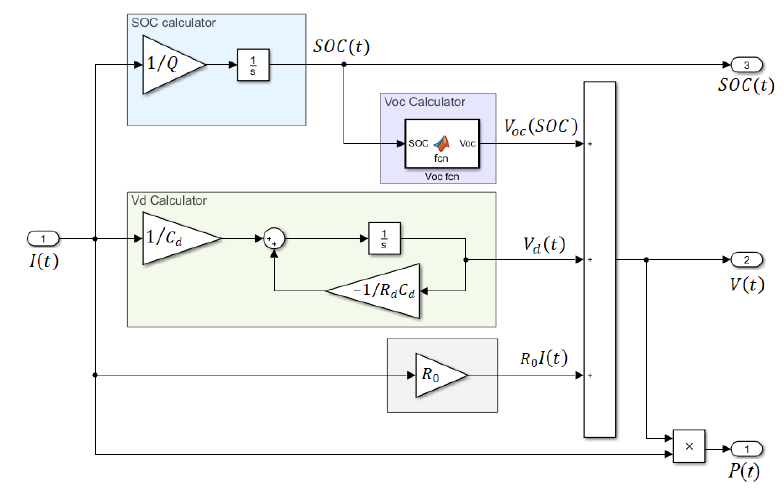
Figure 12. Adopted equivalent-circuit battery model.